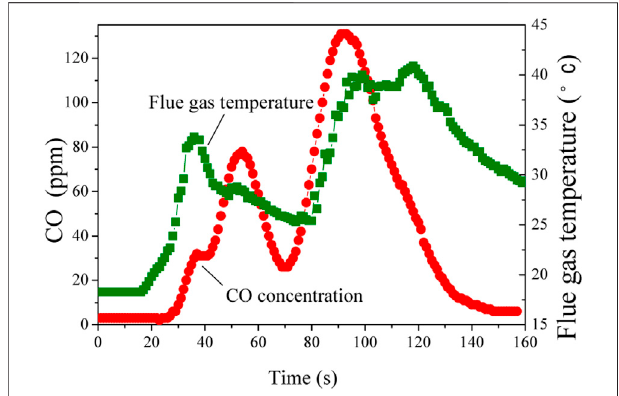
FIGURE 11 | CO concentration and fl ue gas temperature by using compound foam with nano magnesium hydroxide of 20 g/100 ml and water-soluble fl ame retardant 8124 of 30 g/100